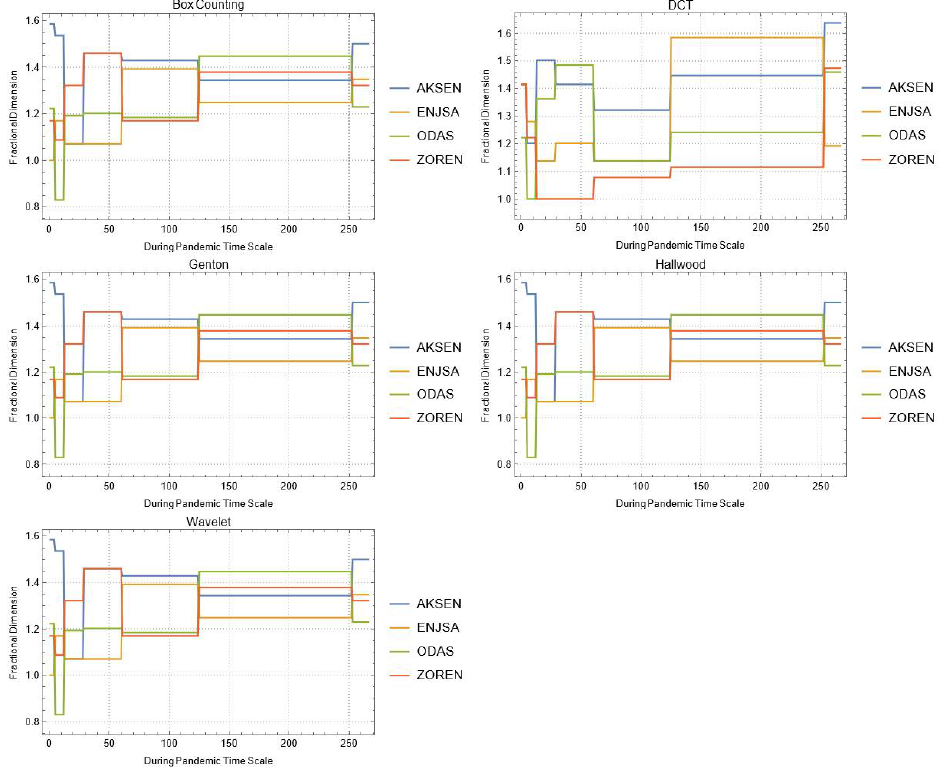
Figure A2. Daily changes of fractal dimensions during the pandemic (energy).